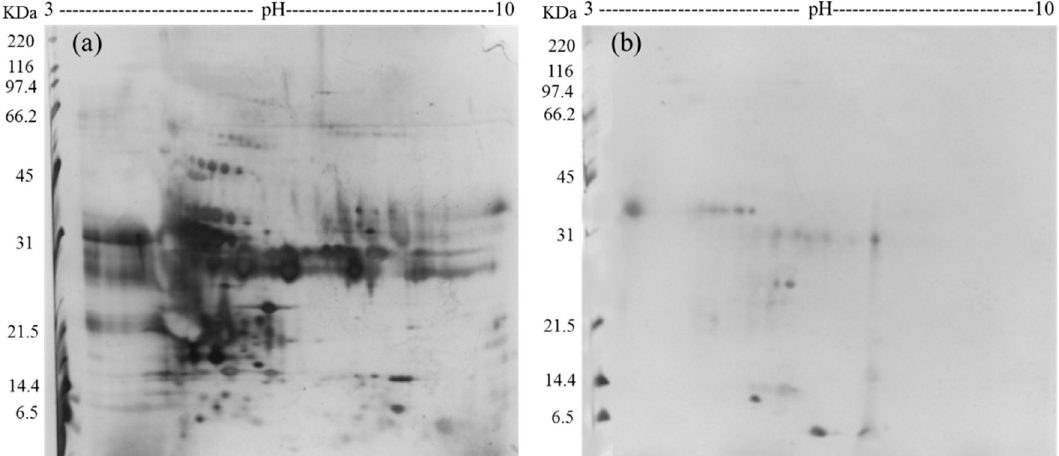
Figure 2. 2D SDS-PAGE analysis of the complete urine (from a healthy donor), not incubated with FCSNP ( a ) and ACN+NH 4 OH elution, final product of the incubation of urine (from same healthy donor) with the FCSNP ( b ). In Figure 2a all proteins (high molecular weight (HMW) and low molecular weight (LMW) proteins) in urine are shown. Simultaneous exclusion of HMW and capture of LMW proteins (~34 kDa and smaller) of the FCSNP was achieved in the ACN+NH 4 OH elution